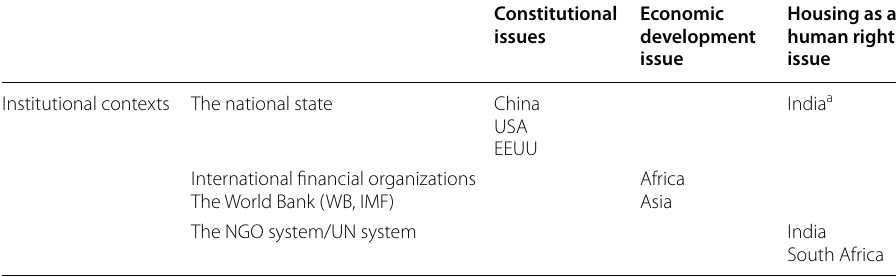
a We use the case of India to illustrate that initiatives often are processed in more than one